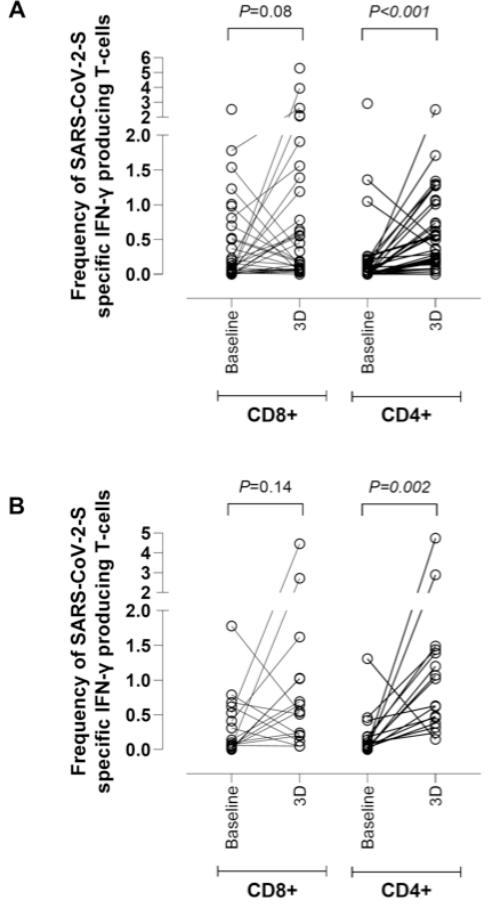
Figure 4. Frequencies of SARS-CoV-2-S- IFN- γ -producing T cells in whole blood as measured by a flow cytometry assay for intracellular cytokine staining in hemodialysis patients ( A ) or kidney transplant recipients ( B ) after receipt of a homologous mRNA COVID-19 third dose (3D) relative to those measured at baseline; p -values for comparisons across groups are